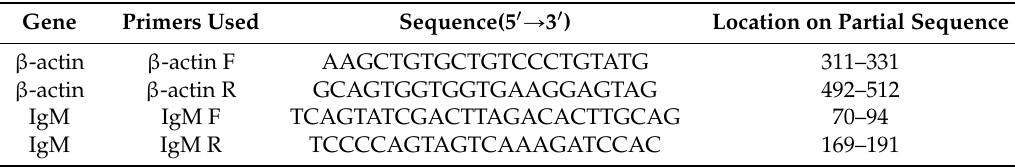
Table 3. Sequences of oligonucleotide primers used in qPCR reactions.